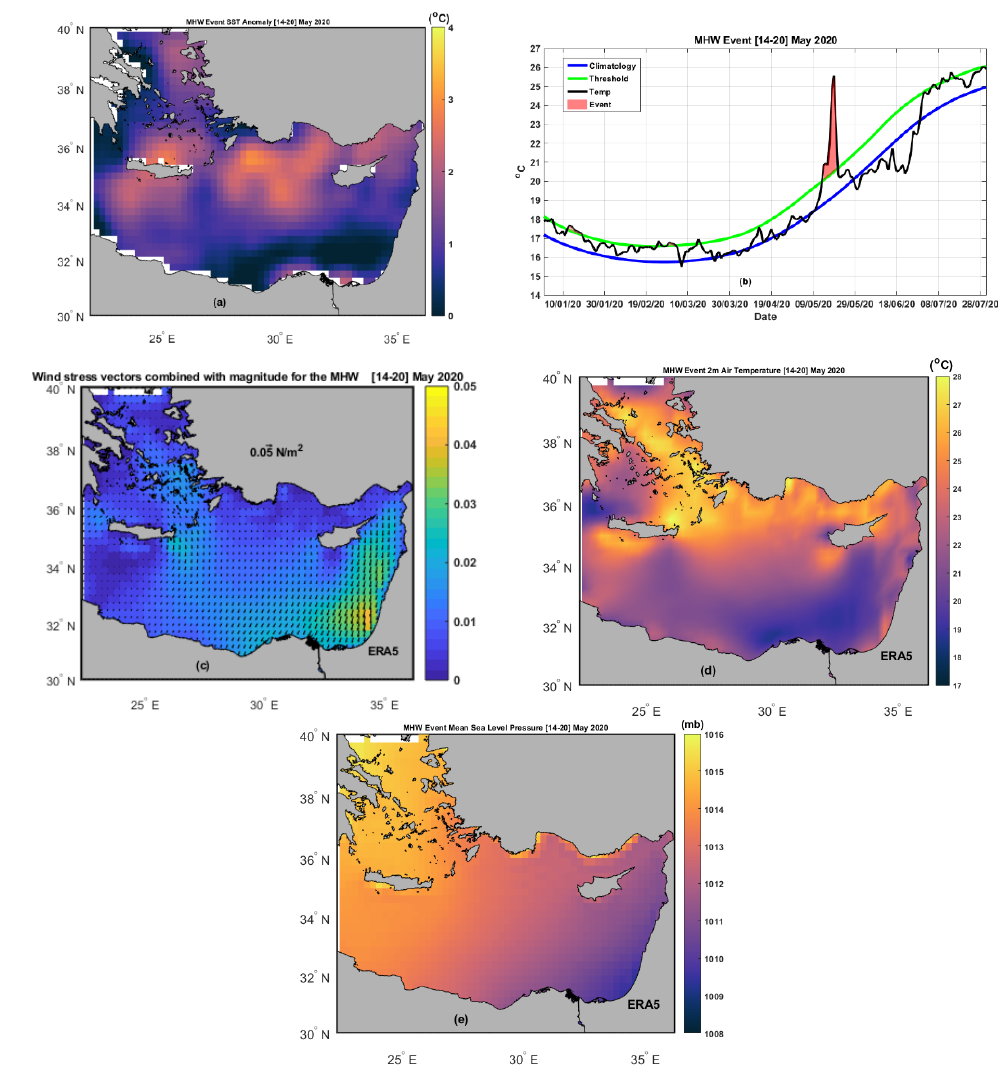
Figure 12. The EMED most significant intense (14–20 May 2020) MHW events over the study period (1982–2020), where, ( a ) MHW mean SST anomaly °C. ( b ) SST climatology from NOAA OI SST for the detection of MHWs (blue), 90 th percentile MHW threshold (green), and SST time series (black) for each MHW. The pink filled area indicates the period associated with the identified MHW event. ( c ) Wind stress vectors combined with magnitude for the MHW in N/m 2 based on ERA5 hourly data. ( d ) 2 m mean air temperature °C based on ERA5 hourly data. ( e ) Mean sea level pressure (mb) based on ERA5 hourly data.